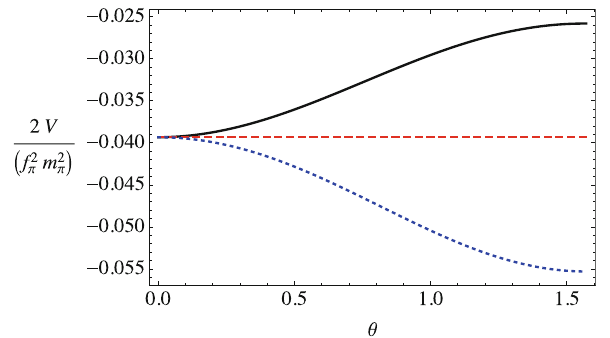
Fig. 3 Potentials as a function of the angular coordinate for the same values of the chemical potentials used in Fig. 2, that is γ B = 1 . 15 and three different values of γ I . The solid black line corresponds to γ = 1 . 12, the dashed red line to γ I γ = 1 . I